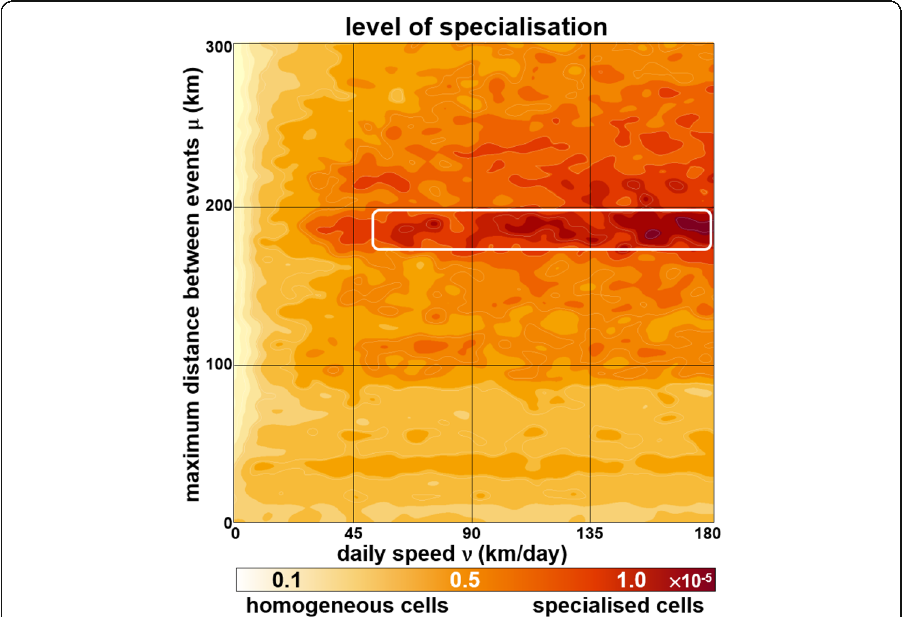
Fig. 3 Metric of specialisation S ( ν , μ ) of Boko Haram cells according to their speed ν and their maximum distance between two consecutive events μ . Cells are more specialised if they commit more attacks, armed clashes, suicide bombs or other types of events than expected. The region inside the white frame had the highest level of specialisation of the whole parameter